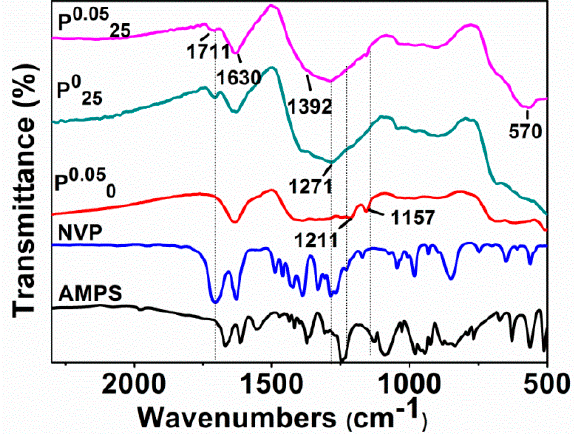
Figure 6. FTIR spectra of AMPS, NVP, and Fe 0 /Fe 3 O 4 microparticles synthesized by adding different organic matters: AMPS, NVP, P 0.05 0 , P 0 25 , and P 0.05 25 from the bottom up.